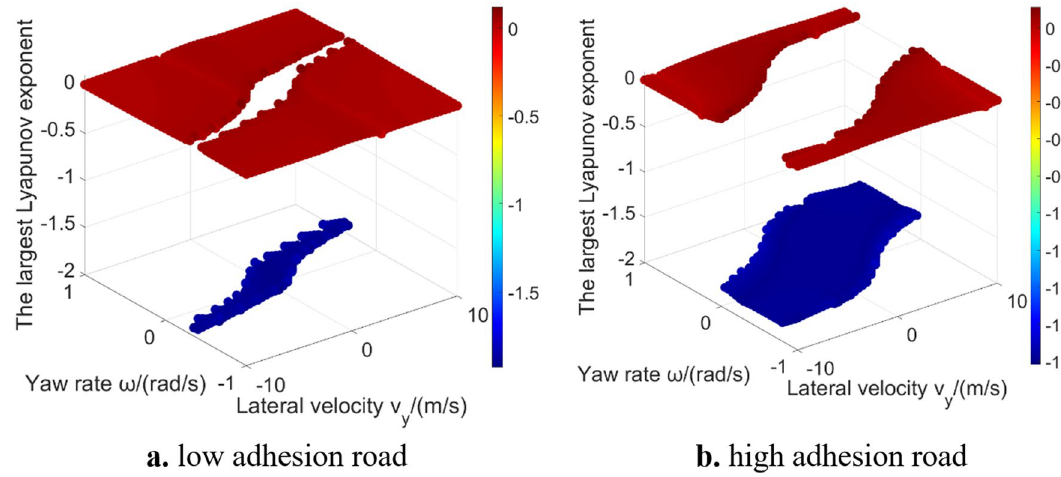
Figure 5. The largest Lyapunov exponent in 2-DOF model global region.